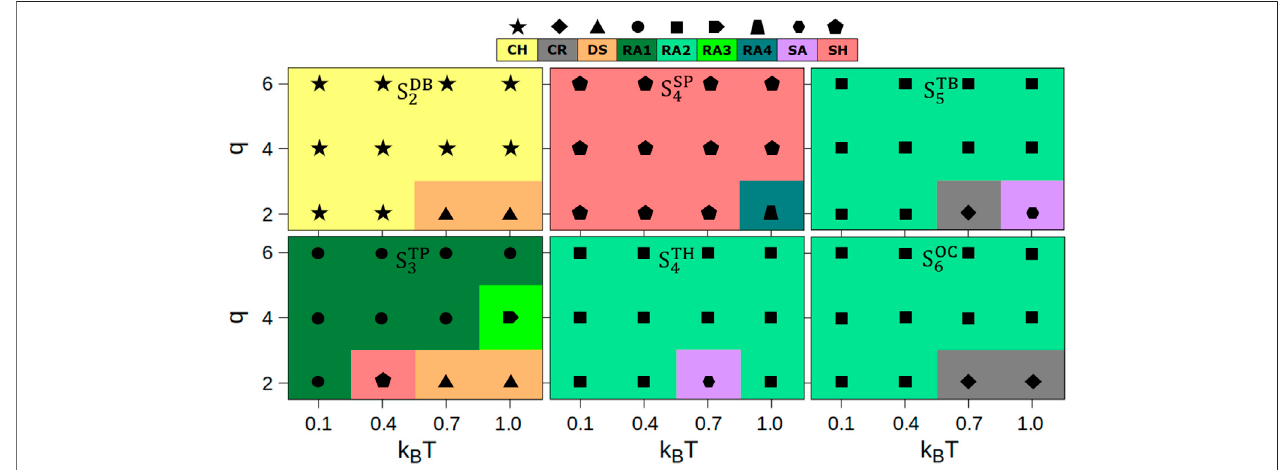
FIGURE 3 | Phase behavior in homogeneous mixtures of charged lobed particles at all charge ( q ) and temperature ( k B T ) conditions. Each type of morphology is color coded: chains (CH), crystalline self-assemblies (CR), random aggregates (RA1, RA2, RA3, RA4), sheets (SH), and spherical aggregates (SR). The conditions at which self-assembly is not observed are labeled as DS, the dissociated